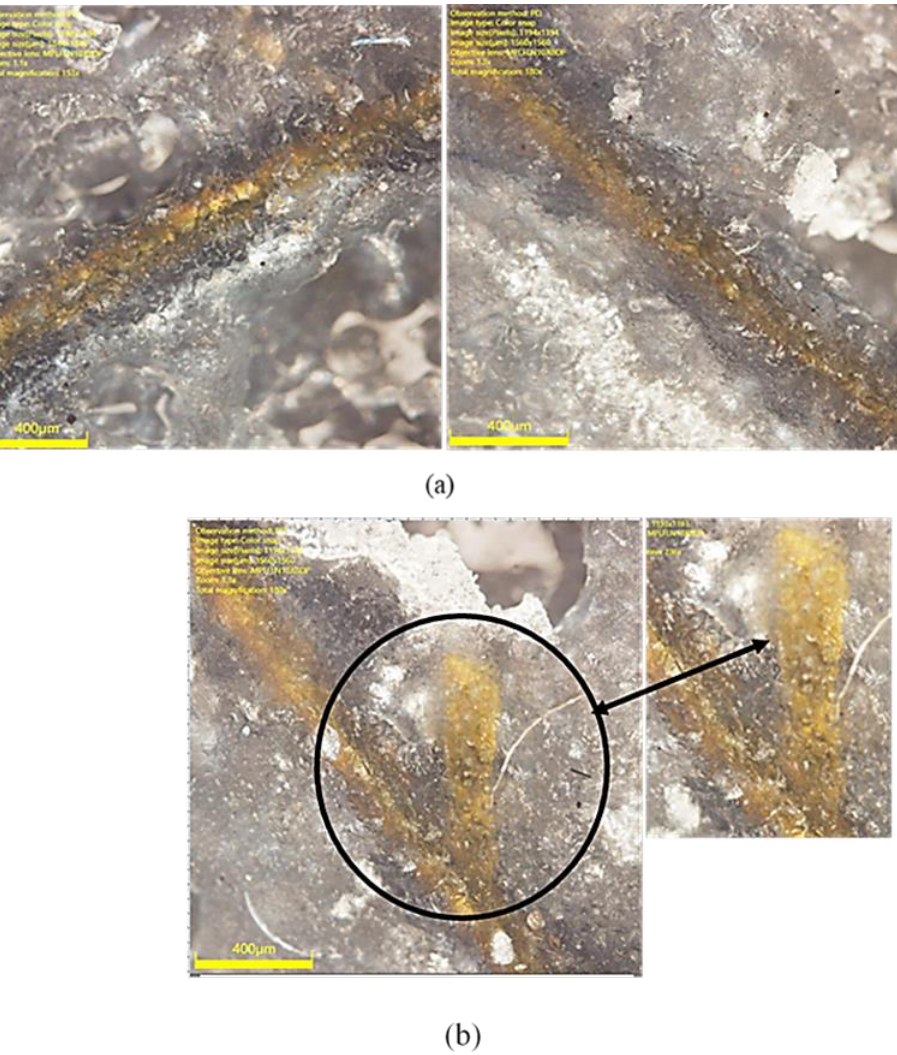
Figure 19. Microscopic images of the surface bonded DFOS: ( a ) intact DFOS coating; ( b ) damaged DFOS coating.